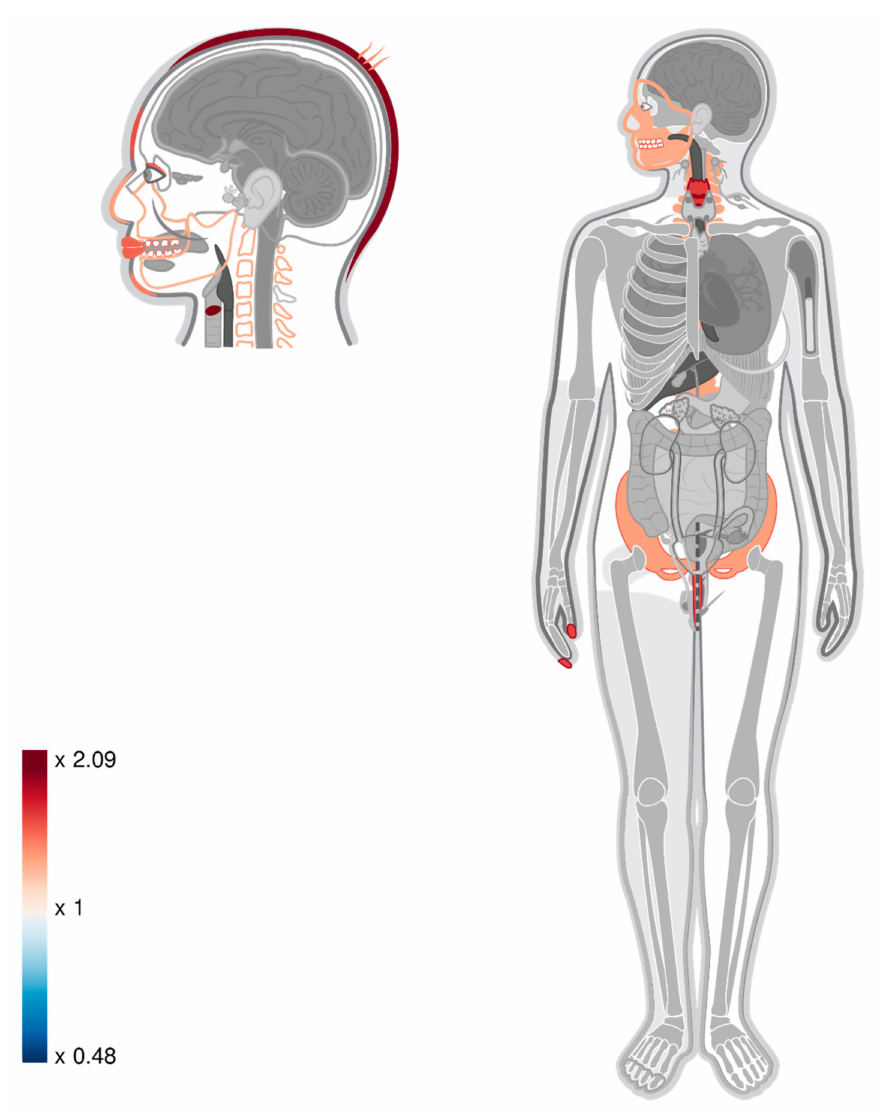
Figure 2. A heat map representing the level of enrichment of each anatomical part within the list of old and new DMGs based on intersection-TADs. Only body parts that are significantly enriched (FDR < 0.05) are colored. Notice the enrichment of genes connected to the chin, hair, scalp, and